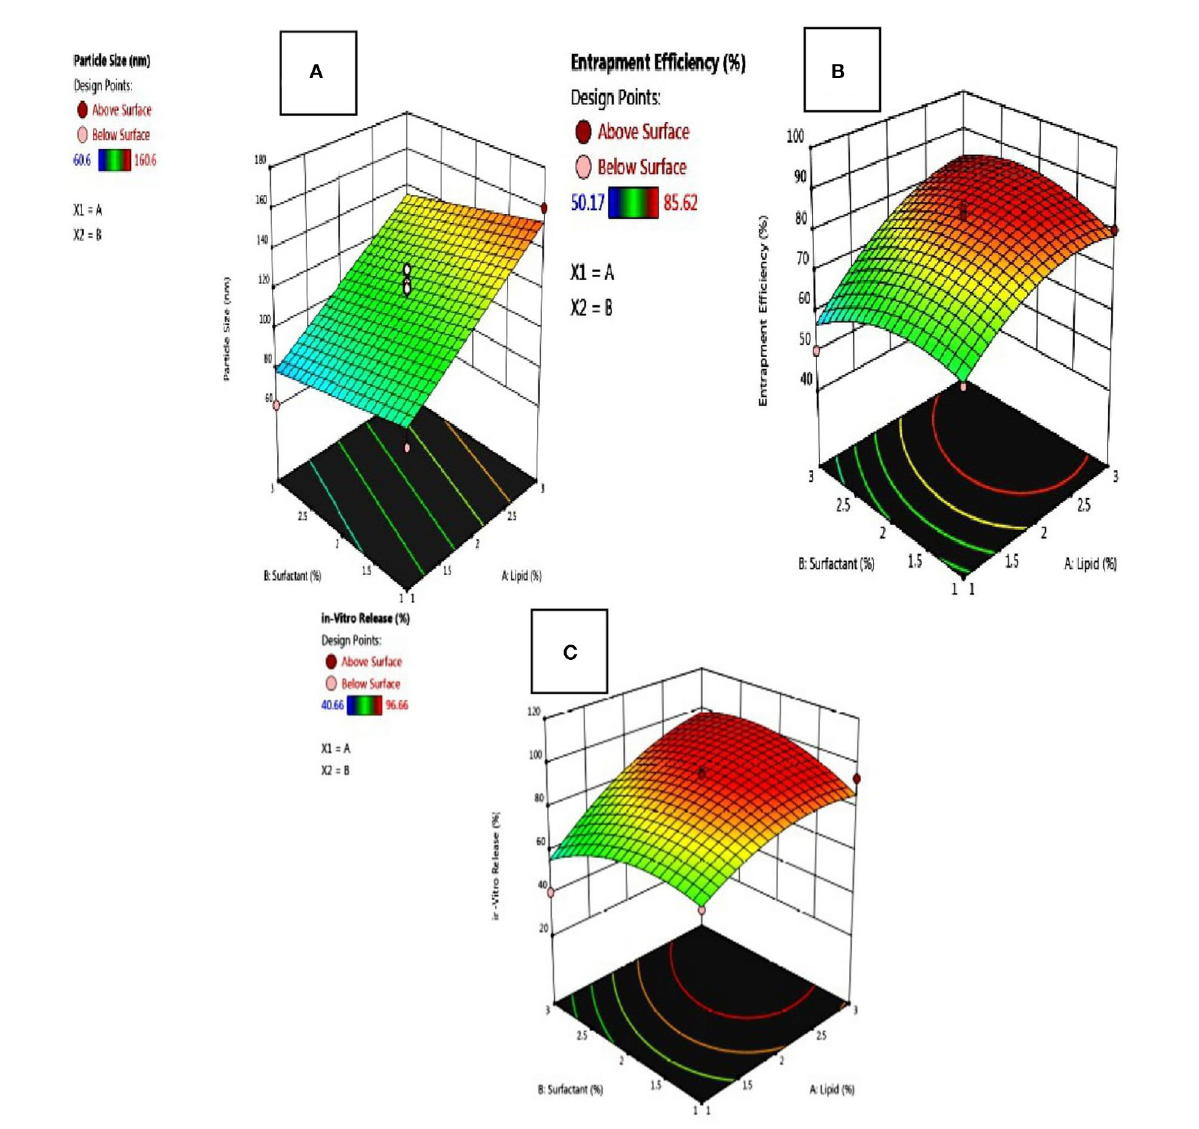
FIGURE3 3-D response surface graphs for (A) particle size, (B) % entrapment efficiency, and (C) in vitro drug